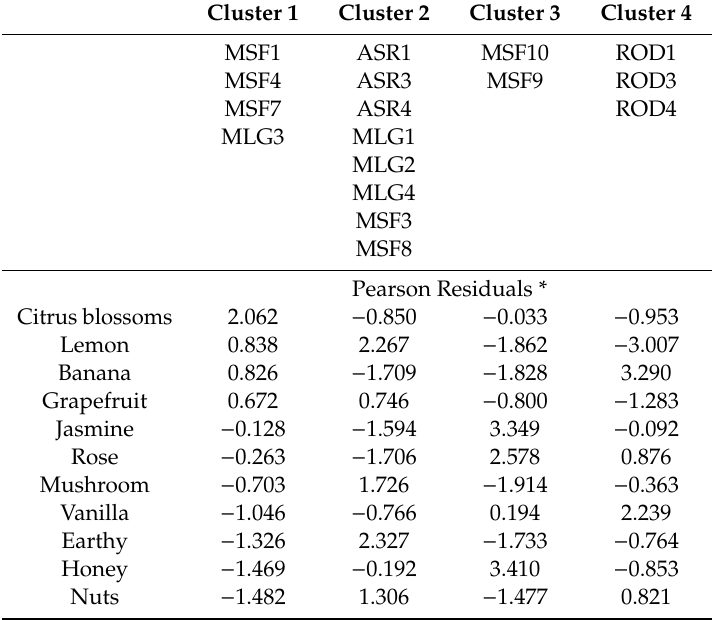
Table 7. The derived clustering solution and Pearson residuals from the deduced contingency